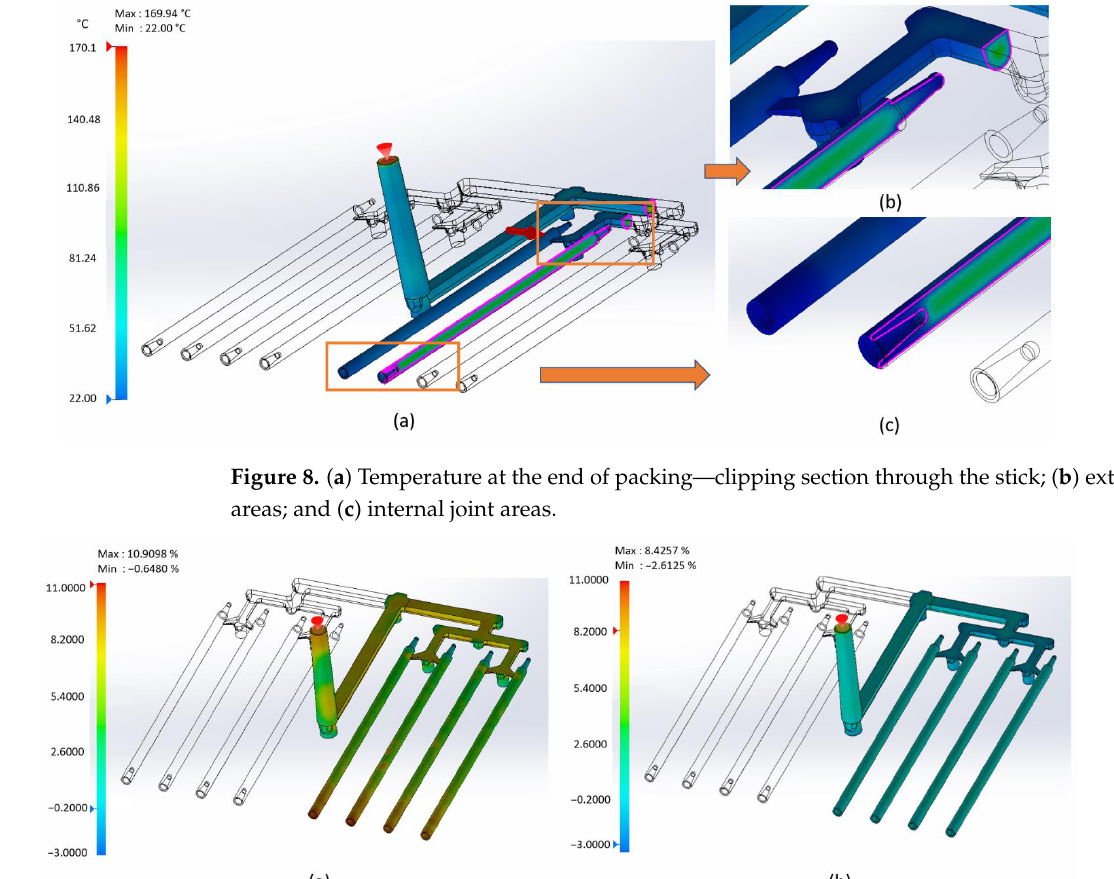
Figure 9. ( a ) Volumetric shrinkage at the end of fill; ( b ) volumetric shrinkage at the end of packing.